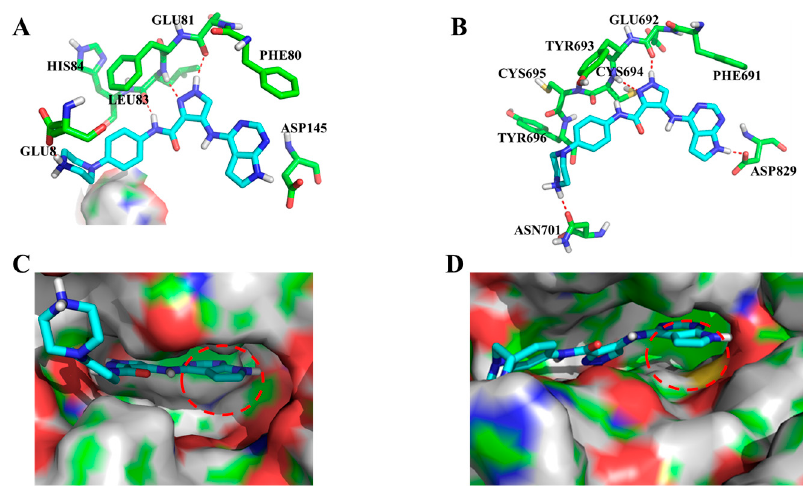
Figure 2. Binding mode analysis of compound 8h bound to cyclin-dependent kinase 2 (CDK2) (PDB code 2VU3) and FLT3 (homology model). Stick model of 8h in CDK2 ( A ) and FLT3 ( B ); Surface model of 8h in CDK2 ( C ) and FLT3 ( D ), Red circle: the deep hydrophobic pocket